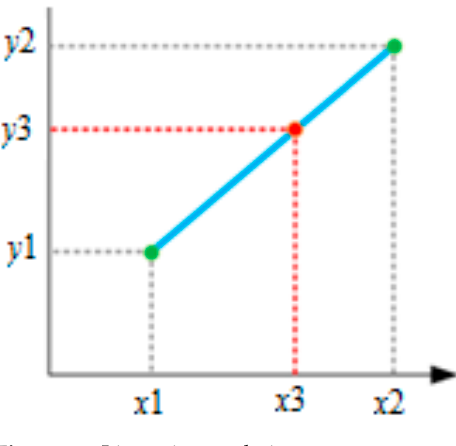
15 of 29 Figure 12. MMI-to-throughput tables for modulation schemes. 3.7. Function Interp The inputs to the interp function are the y 1 float data type (the y -axis value of table variable 1), the y 2 float data type (the y -axis value of the table variable 2), the dx_inv float data type (the inverse of the interval between the x -axis values of table variable 1 and table variable 2), and the a float data type (the difference between the x -axis value of the input and the x -axis value of table variable 1). The interp function conducts linear interpolation and the related operation is shown in Equation (12) with an example drawn in Figure 13. 2